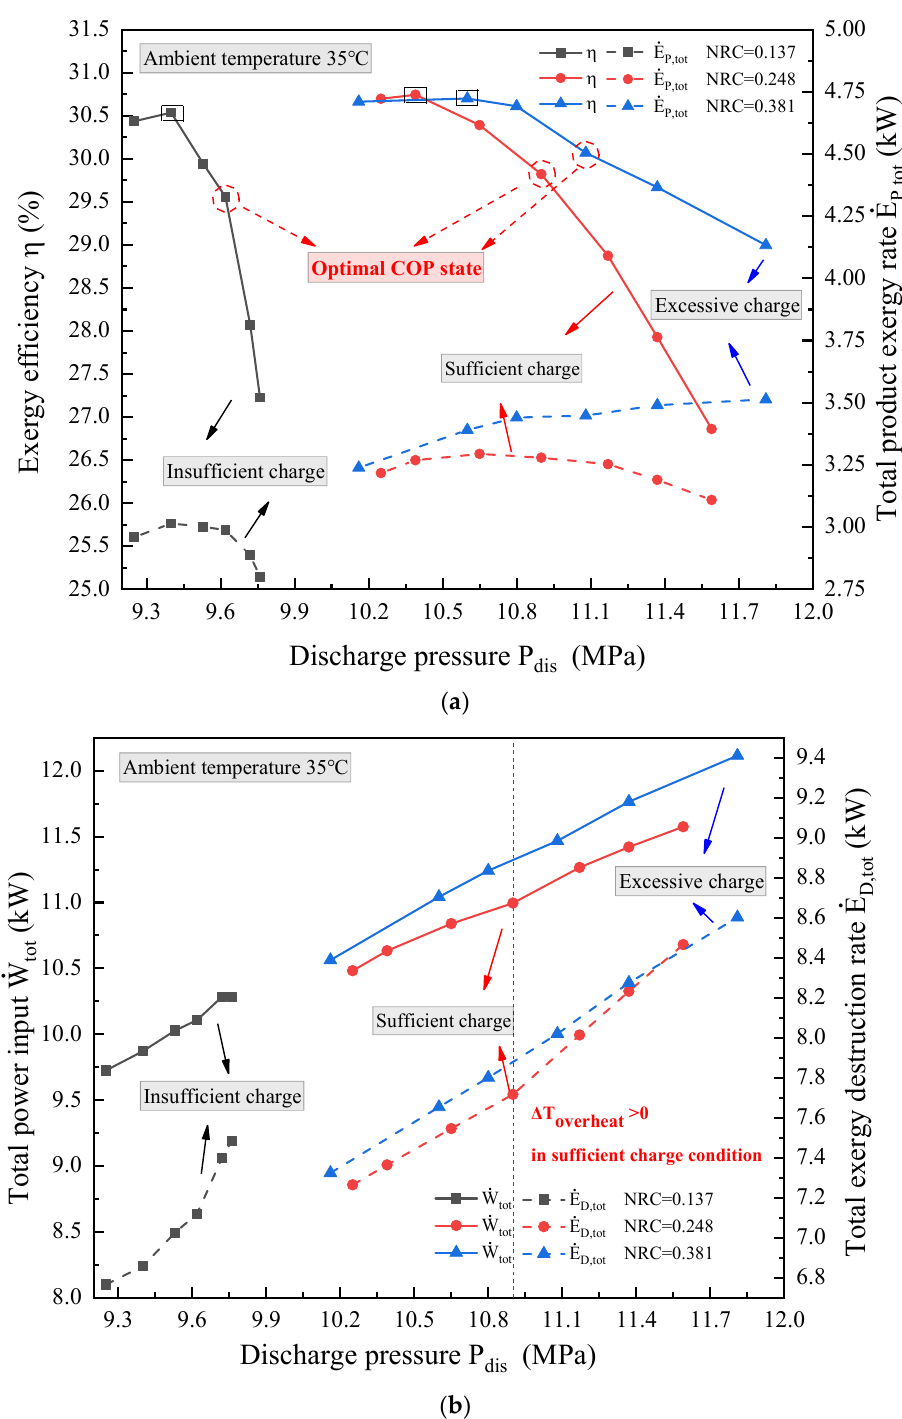
Figure 7. The effect of discharge pressure (P dis ) on ( a ) exergy efficiency (η) and total product exergy rate ( 𝐸̇ (cid:3017),(cid:3047)(cid:3042)(cid:3047) ) as well as on ( b ) total power input ( 𝑊̇ (cid:3047)(cid:3042)(cid:3047) ) and total exergy destruction rate ( 𝐸̇ (cid:3005),(cid:3047)(cid:3042)(cid:3047) ) at ambient temperature of 35 °C.